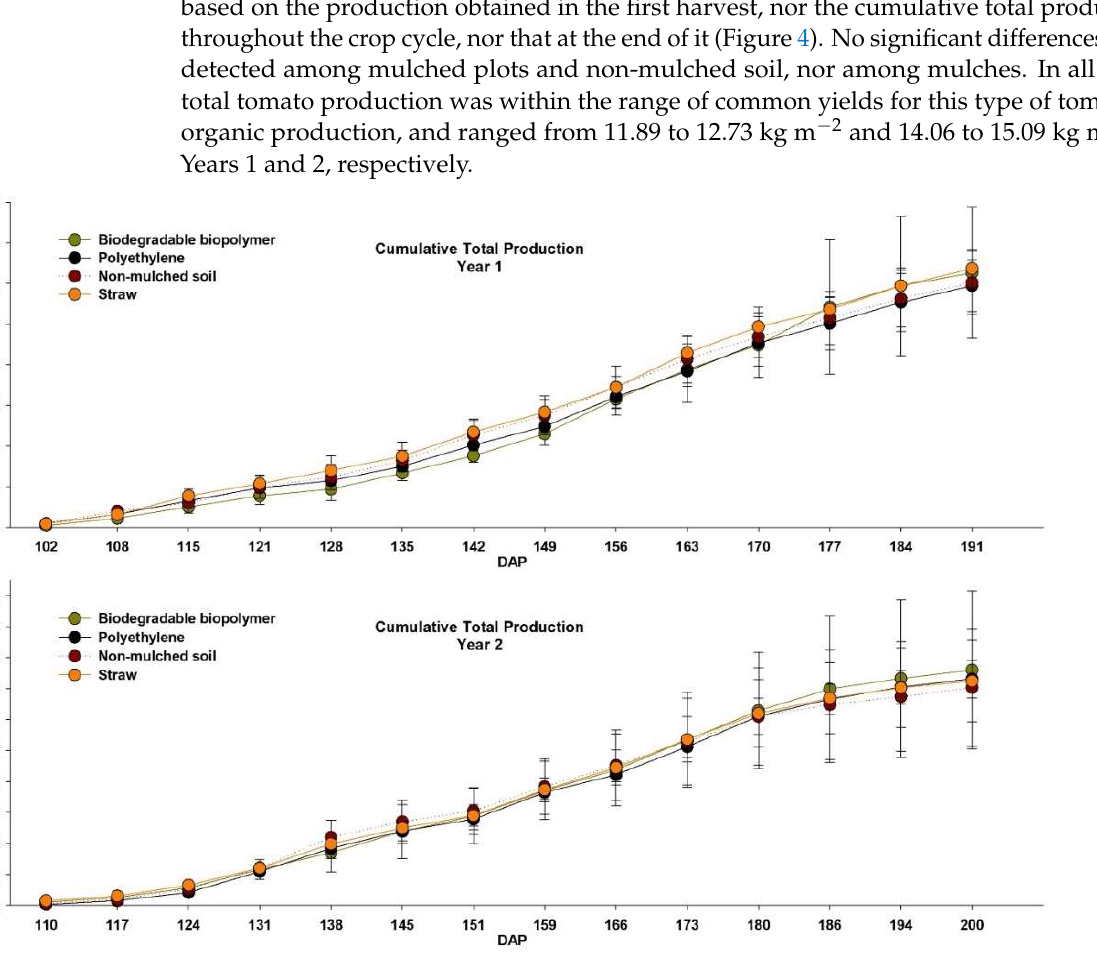
Figure 4. Cumulative tomato production in the two years of study depending on mulch type and for non-mulched soil. Values (mean ± standard deviation; n = 3). DAP: Days After Planting. Similarly, soil mulch did not significantly influence the number of fruits per m 2 , with average values ranging from 36.1 to 39.6 fruits m −2 and 52.2 to 57.4 fruits m −2 in Years 1 and 2, respectively (Figure 5). In this regard, it should be noted that the differences in production and number of fruits between the two years of study (higher values in the